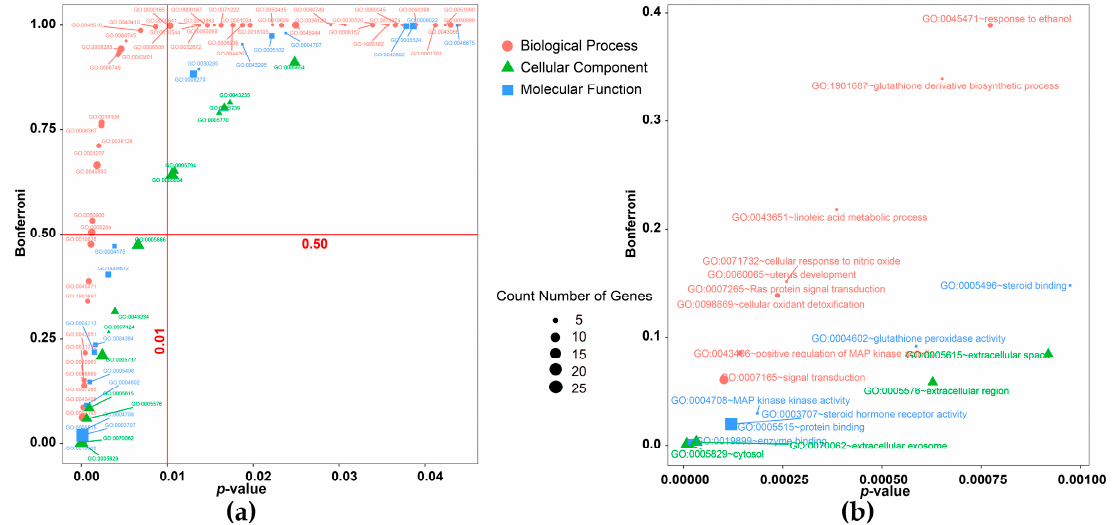
Figure 4. GO enrichment scatter plot for the top 30 putative target proteins. Only GO terms with a p -value ≤ 0.05 are shown in panel ( a ), and terms with a p -value ≤ 0.001 are shown in panel ( b ). Table 1. The classification results of Biological Process terms.